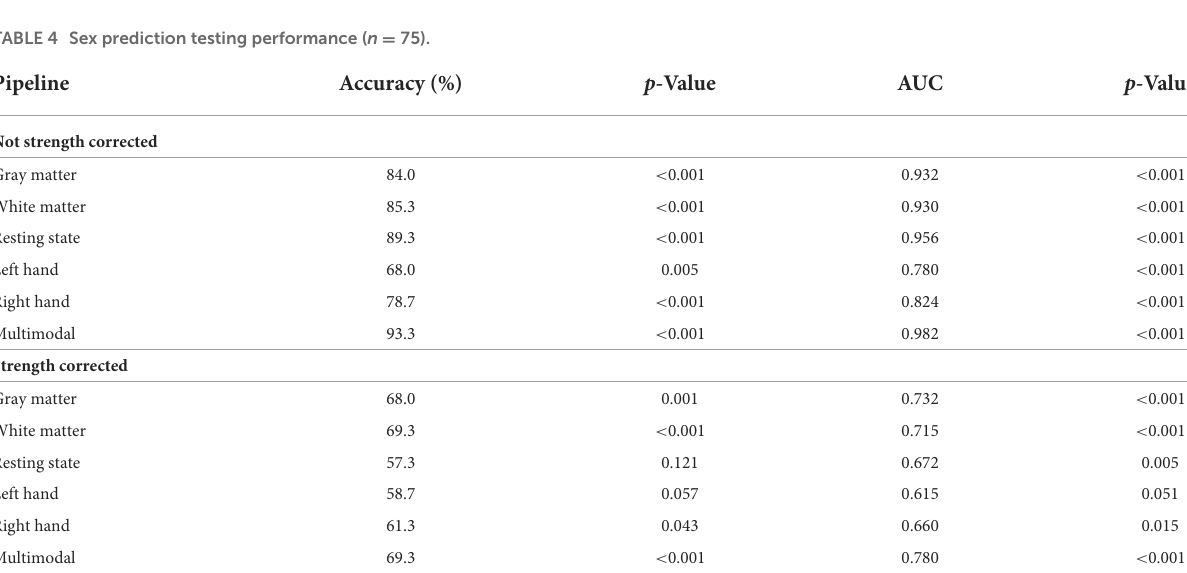
TABLE 4 Sex prediction testing performance ( n =